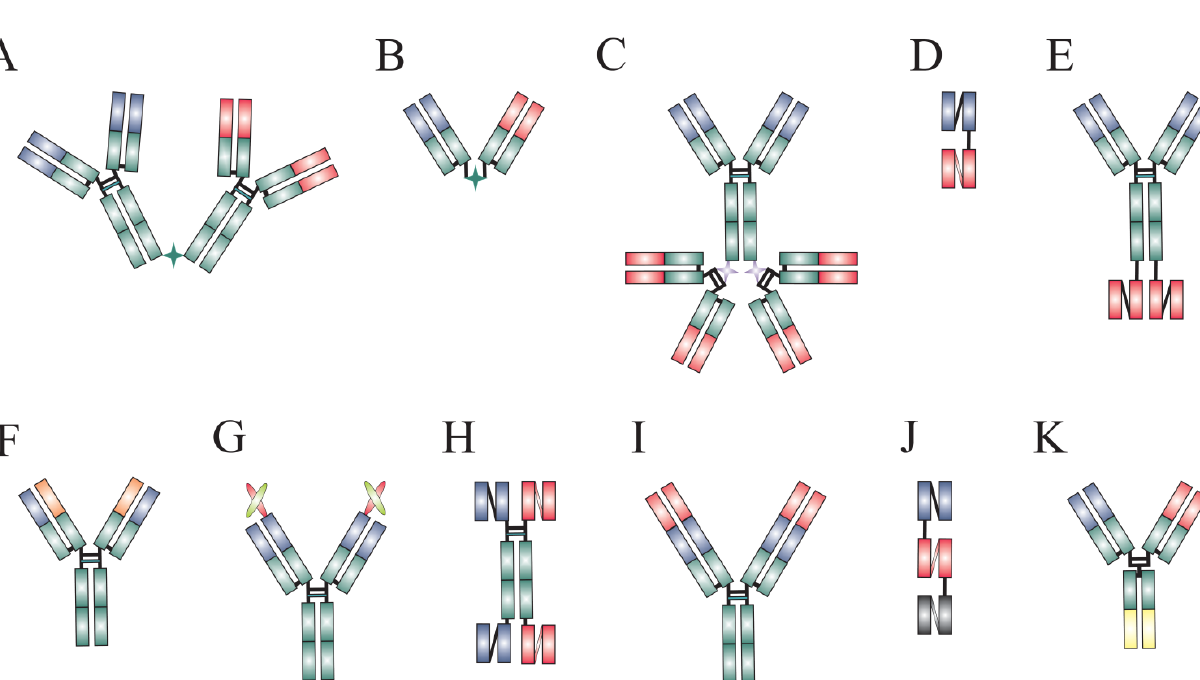
Figure 1. Schematic structure of dual-targeting agents. ( A ) cross linked monoclonal